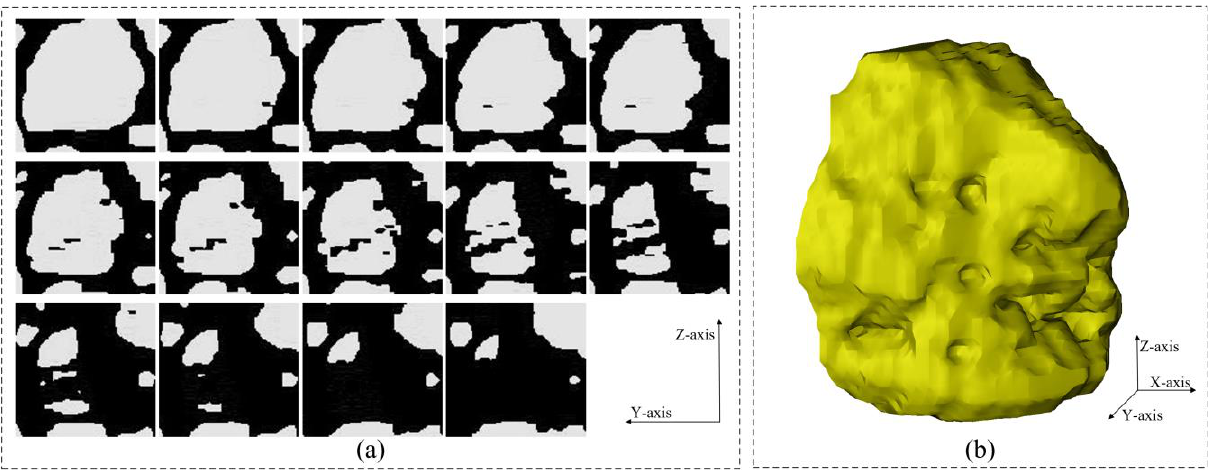
Figure 17. Schematic diagram of the concave contour of the aggregate: ( a ) 2D slice; ( b ) 3D model (Figure 10d).